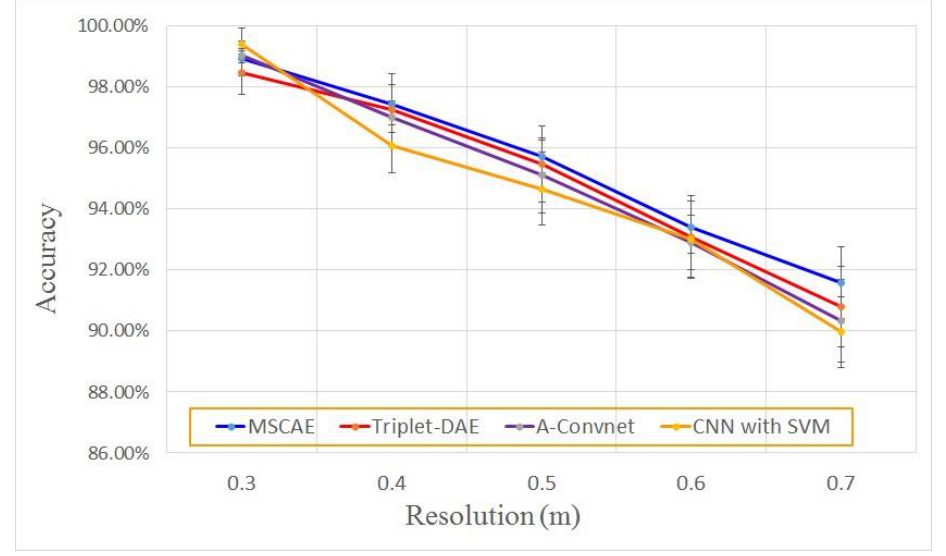
Figure 17. Classification results at different resolutions.